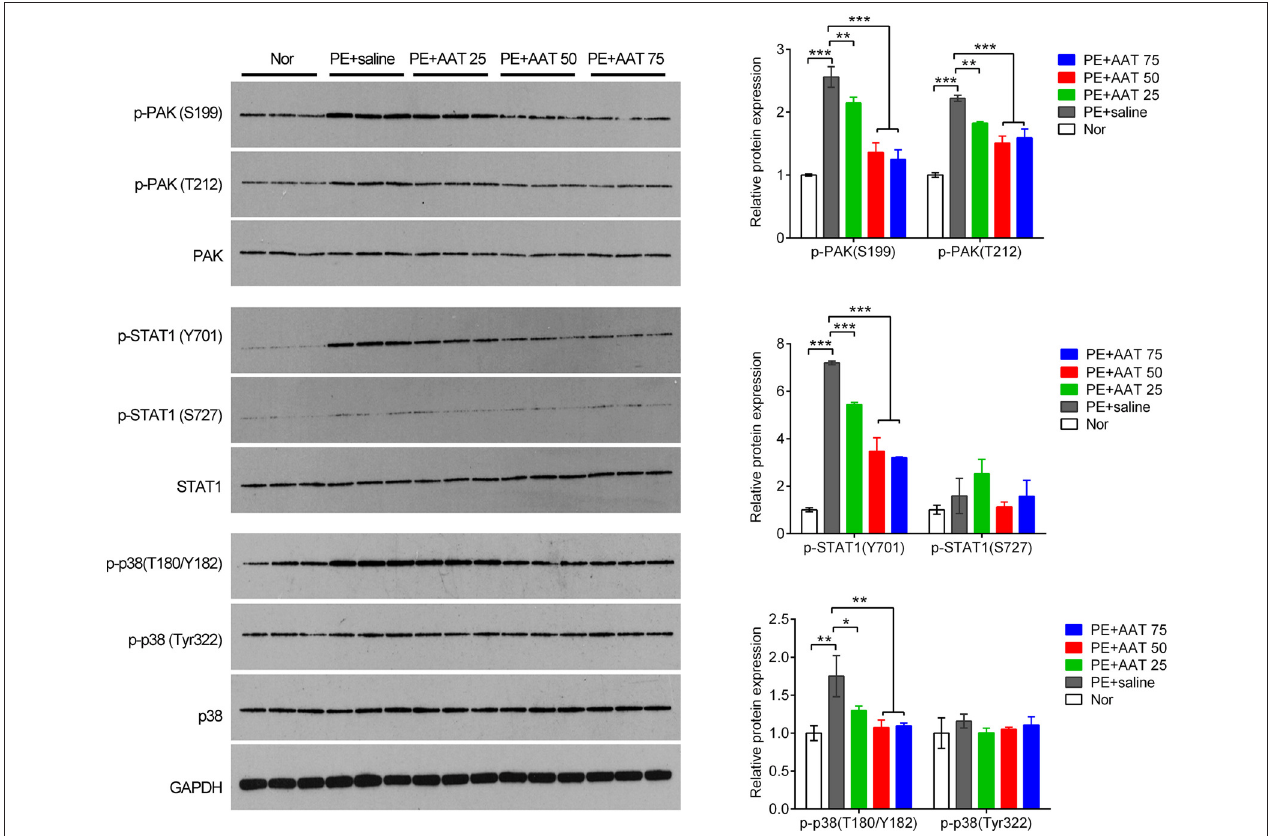
FIGURE 4 | AAT inactivates PAK/STAT1/p38 signaling that enhanced by PE. Western blot analysis for PAK, phosphorylated PAK, STAT1, phosphorylated STAT1, p38 and phosphorylated p38 in mice placenta. N = 3 . * p < 0.05 , ** p < 0.01 , *** p < 0.001